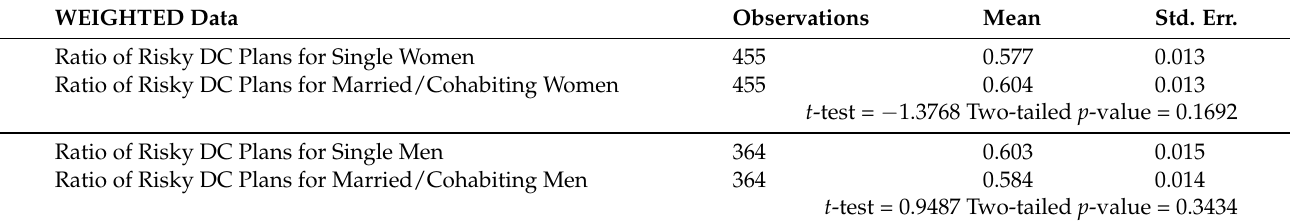
Table 11. Paired t -tests for Single and Married/Cohabiting